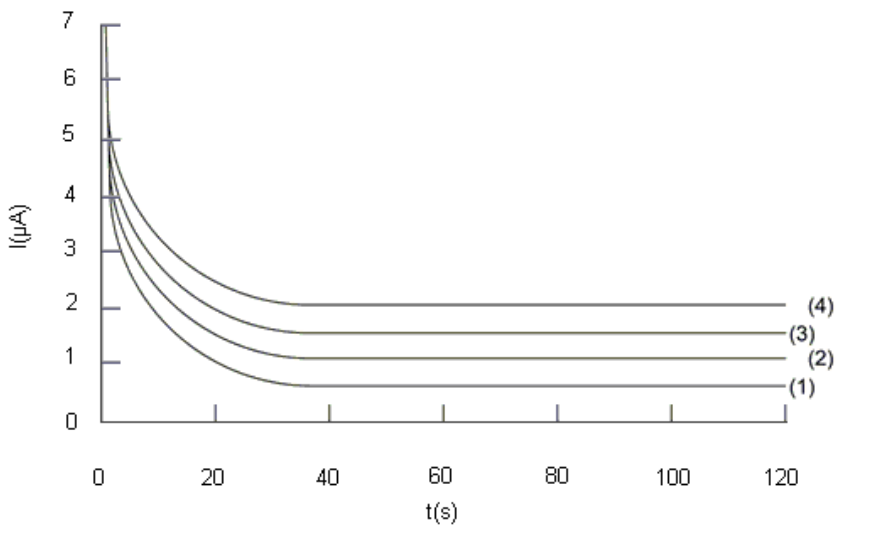
Figure 4 . Chronobiamperograms illustrating the influence of the potential difference, Δ E: (1) 50 mV, (2) 100 mV, (3) 150 mV, (4) 200 mV; conditions: DPPH· concentration = 100 µM, DPPH concentration = 110 µM; (for details see Experimental).